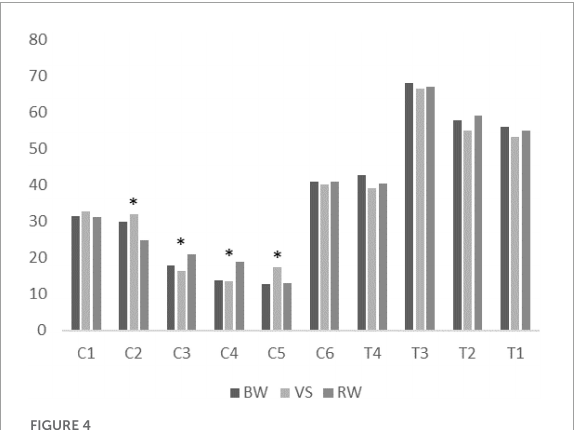
FIGURE4 Mean proportion of muscle synergies for each walking condition in individual clusters. BW, baseline walking condition; VS, varying speed condition; RW, restricted width walking condition. ∗ : Statistically significant difference among task